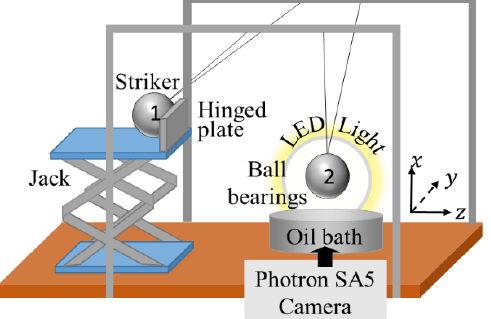
Fig. 2. Experimental Stokes’ cradle